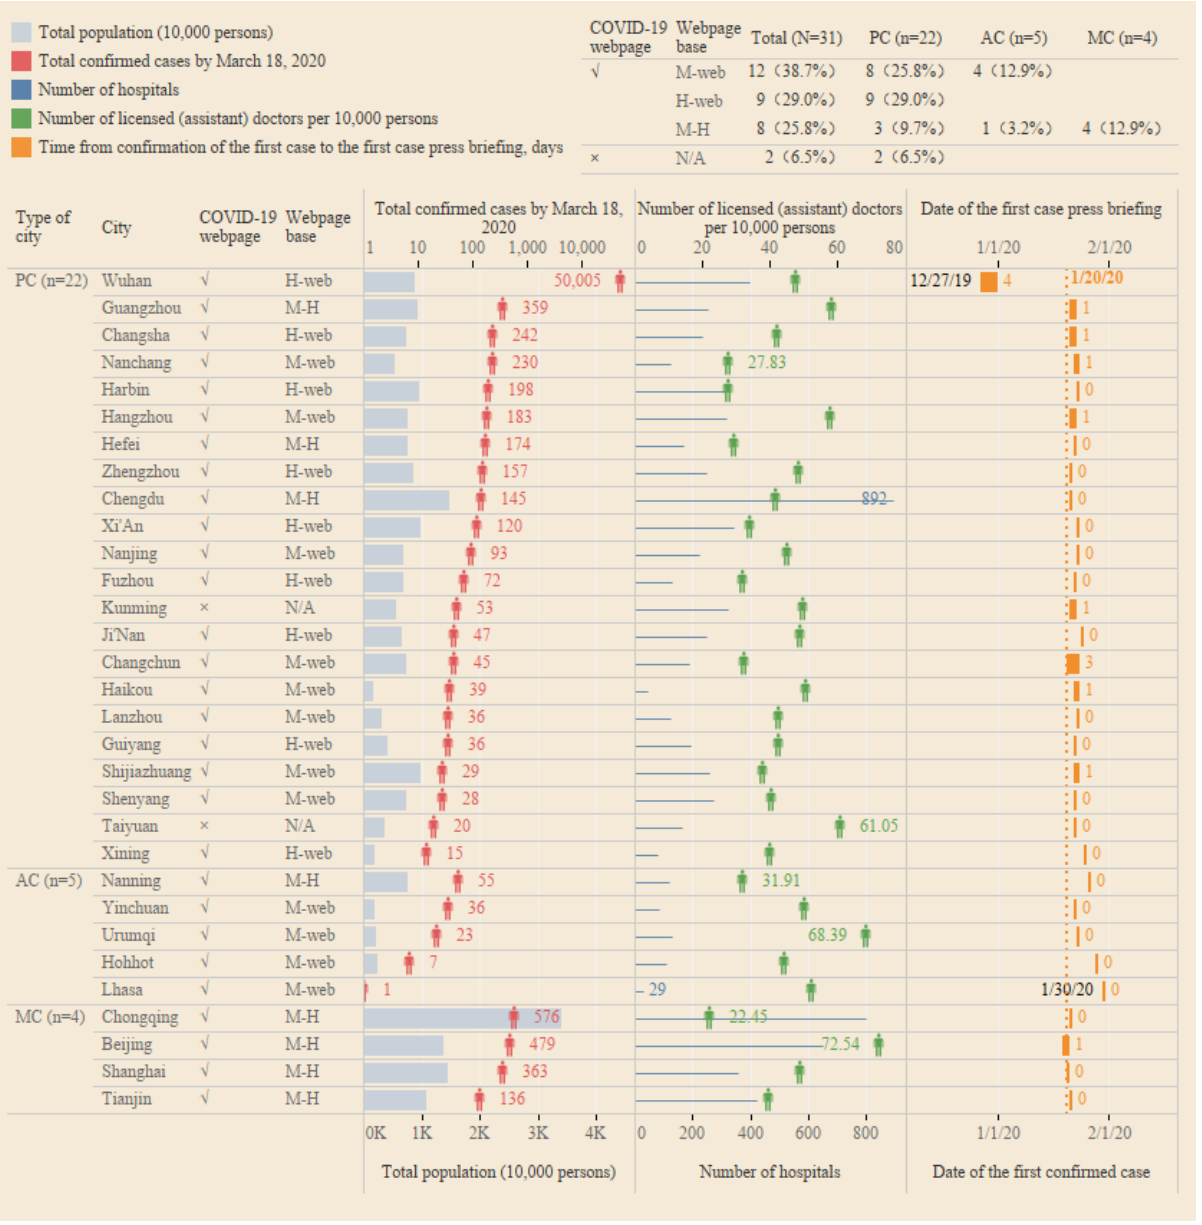
Figure 1. Characteristics of cities with confirmed COVID-19 cases included in this analysis. Data on total population, number of hospitals, number of licensed (assistant) doctors per 10,000 persons as of 2018 were obtained from the China Statistical Database. Chinese scientists identified the pathogen as a novel coronavirus on January 7, 2020. The first case with symptoms of the novel coronavirus in Wuhan was identified and reported to the authorities on December 27, 2019, by Jixian Zhang, the director of the Department of Respiratory and Critical Care Medicine of Hubei Provincial Hospital of Integrated Chinese and Western Medicine. China’s National Health Commission incorporated COVID-19 as a notifiable disease in the National Infectious Disease Law and the Frontier Health and Quarantine Law on January 20, 2020. AC: autonomous region capital; H-Web: health department website; MC: municipality administered by the central government; M-H: both municipality and health department websites; M-Web: municipality website; N/A: not applicable; PC: provincial